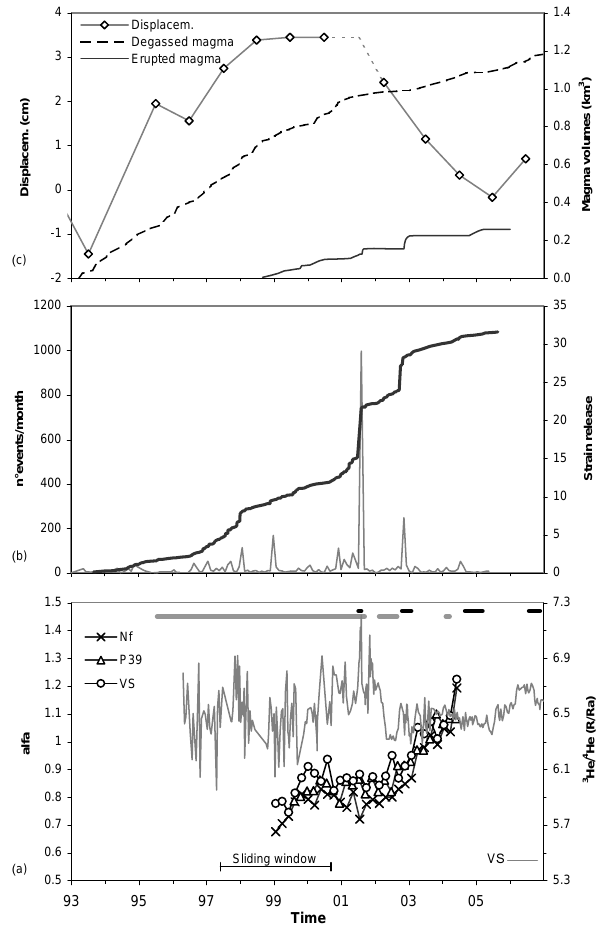
Figure 12 . Variations of some geochemical and geophysical parameters during the period 1993- 2006. a) unhandled He isotopic time series from VS site (grey curve), and local α exponents of the isotopic GS (symbols). The time length of the sliding window for calculating local α is displayed (see text). The horizontal lines on the top indicate the main eruptive phases: summit activities (thick grey segments) and flank eruptions of 2001, 2002-03, 2004 and 2006 (black segments); b) seismicity expressed as both monthly rate of events and strain release; c) one-year mean vertical displacement of the volcanic cone, and cumulative erupted and degassed magma ( see Allard et al. 2006, Neri et al. 2009, and their references for sources of geophysical data ) .